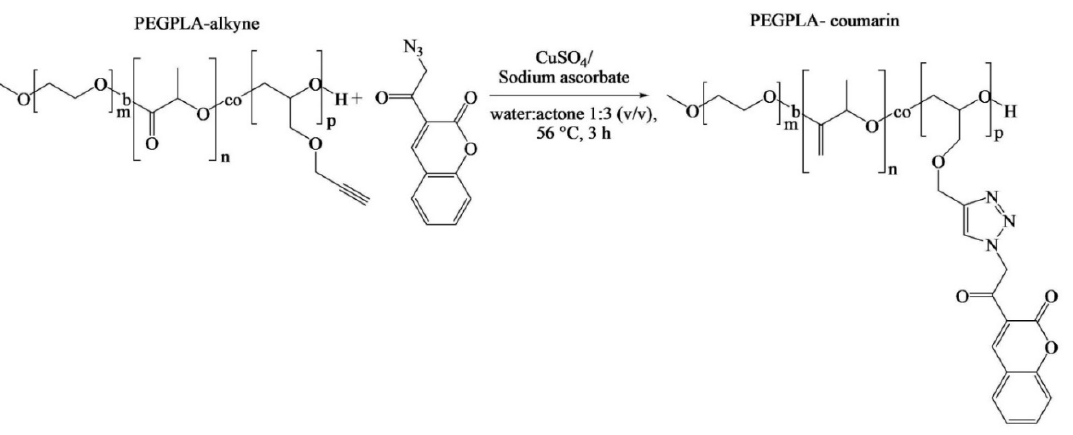
Figure 5. Reaction scheme for the preparation of alkyne-functional PEG- b -P(LA- co -PGE)-coumarin conjugate as described by Pound-Lana et al. Adapted with permission from [36]; published by Elsevier, 2017.